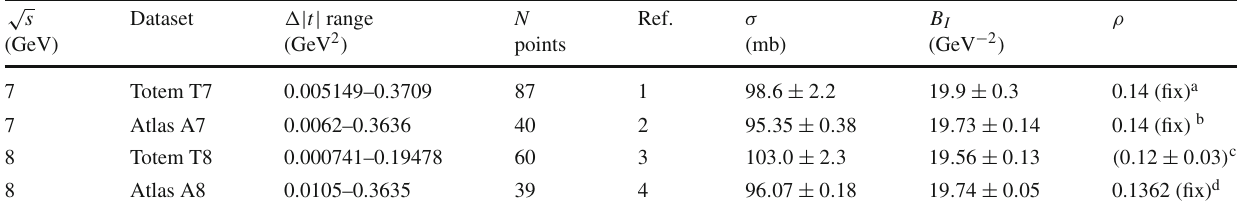
√ s = 7 and 8TeV from Totem and Atlas Table 1 Measurements at with a forward SET-I and kept fixed in a complete SET-II as explained Collaborations at LHC [1–5]. The ρ values for a b are taken from COM- in the section with the analysis of T8. For d the ρ value is taken PETE Collaboration [19]. For c the ρ value was obtained by the authors